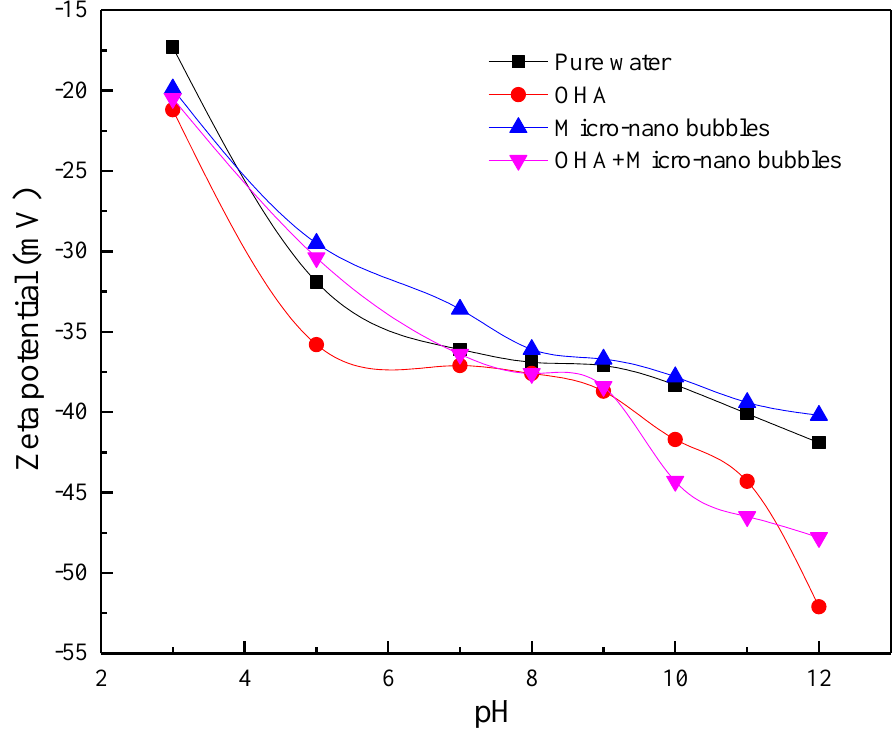
Figure 7. The relationship between the Zeta potential of wolframite and pH.